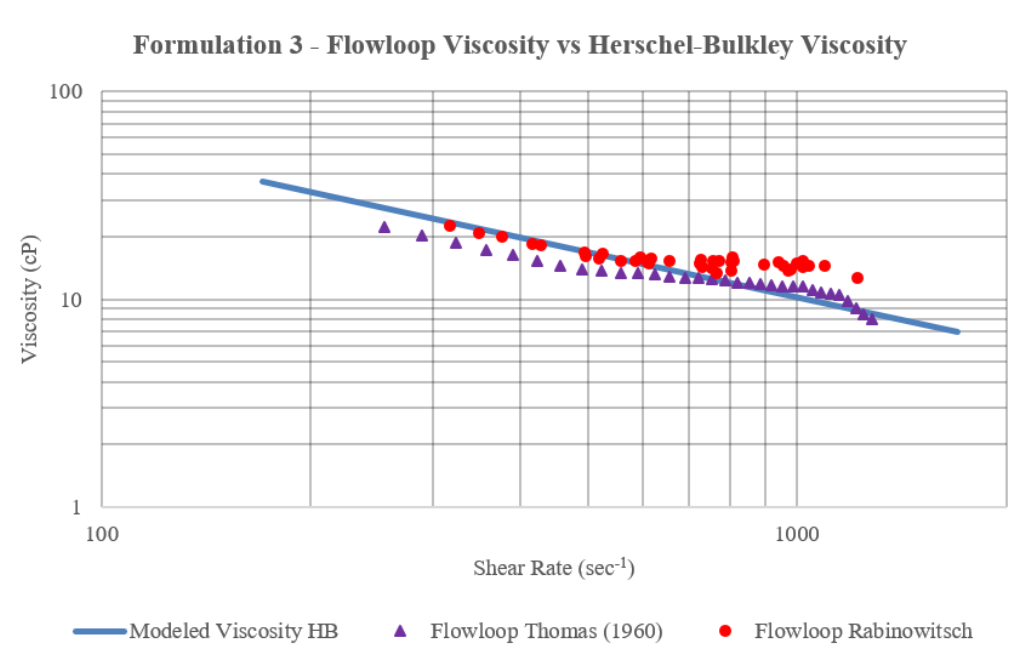
Figure 8: Estimated viscosity of Formulation